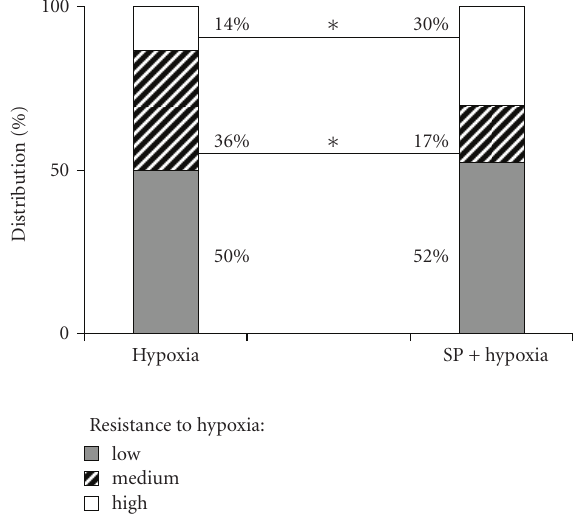
Figure 4: Influence of the pre-treatment with 5 mg/kg SP on the resistance of pregnant rats to acute hypobaric hypoxia. Statistical significance: ∗ P < . 05